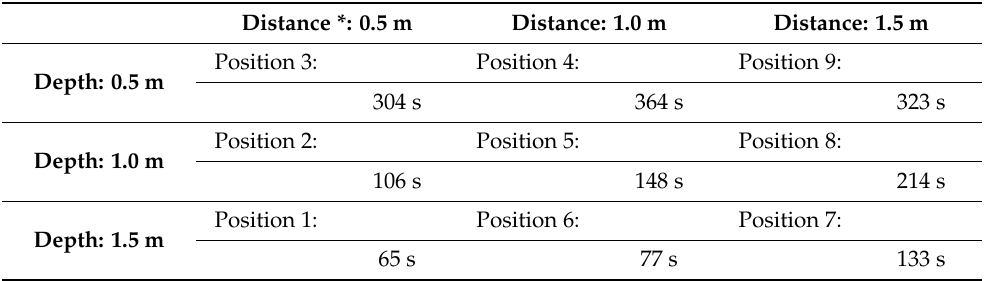
Table 3. Residence time of bubbles calculated at different sampling positions from